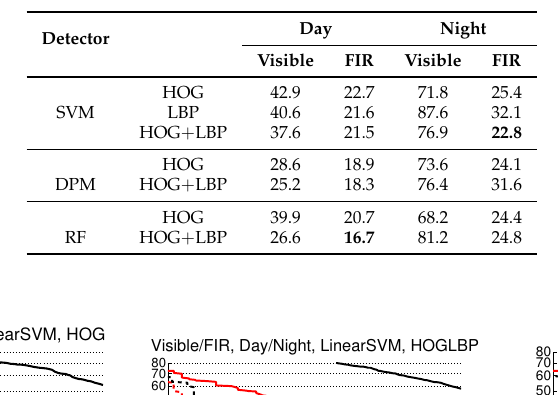
Table 3. Average miss rate (AMR) in the CVC-14 dataset.